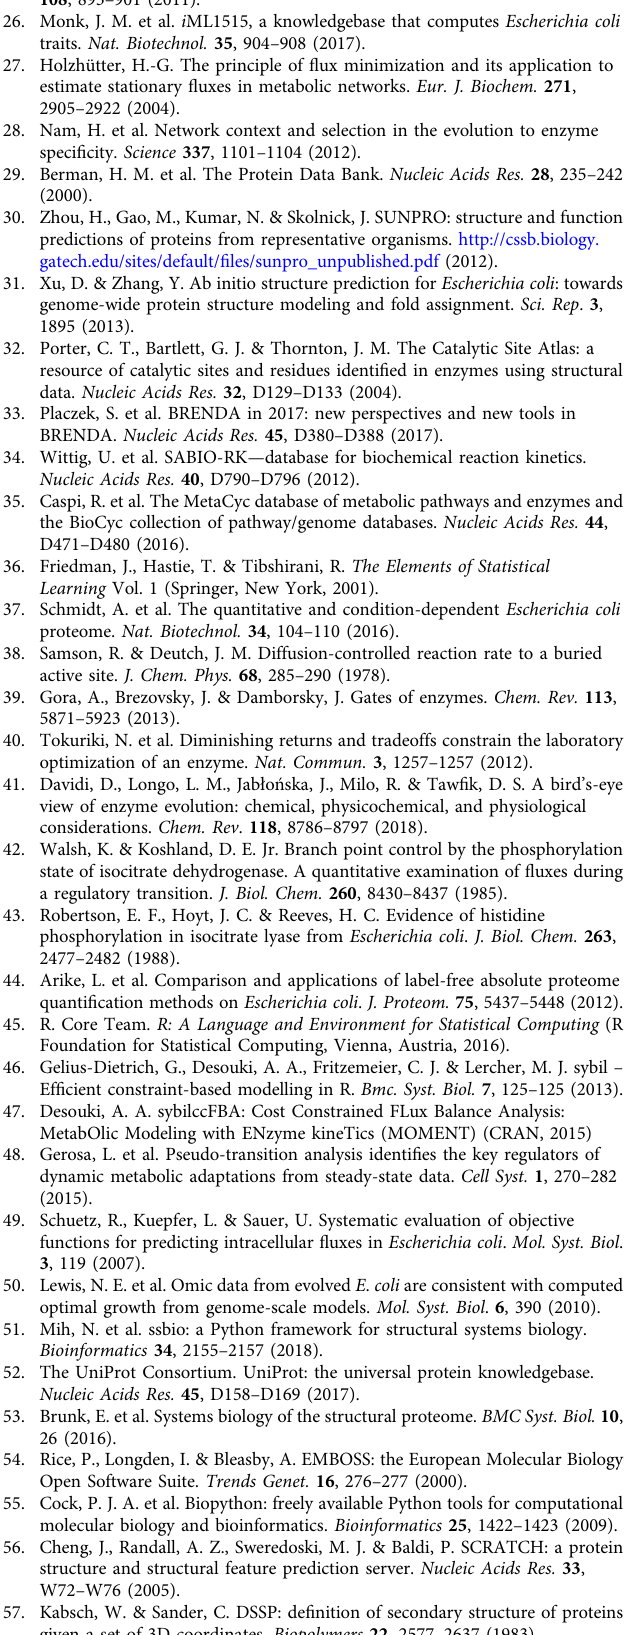
Data availability The vectors of turnover numbers predicted by our ensemble models alongside the experimental benchmarks used in Fig. 4 are available as Supplementary Data 1. A Reporting Summary for this Article is available as a Supplementary Information fi